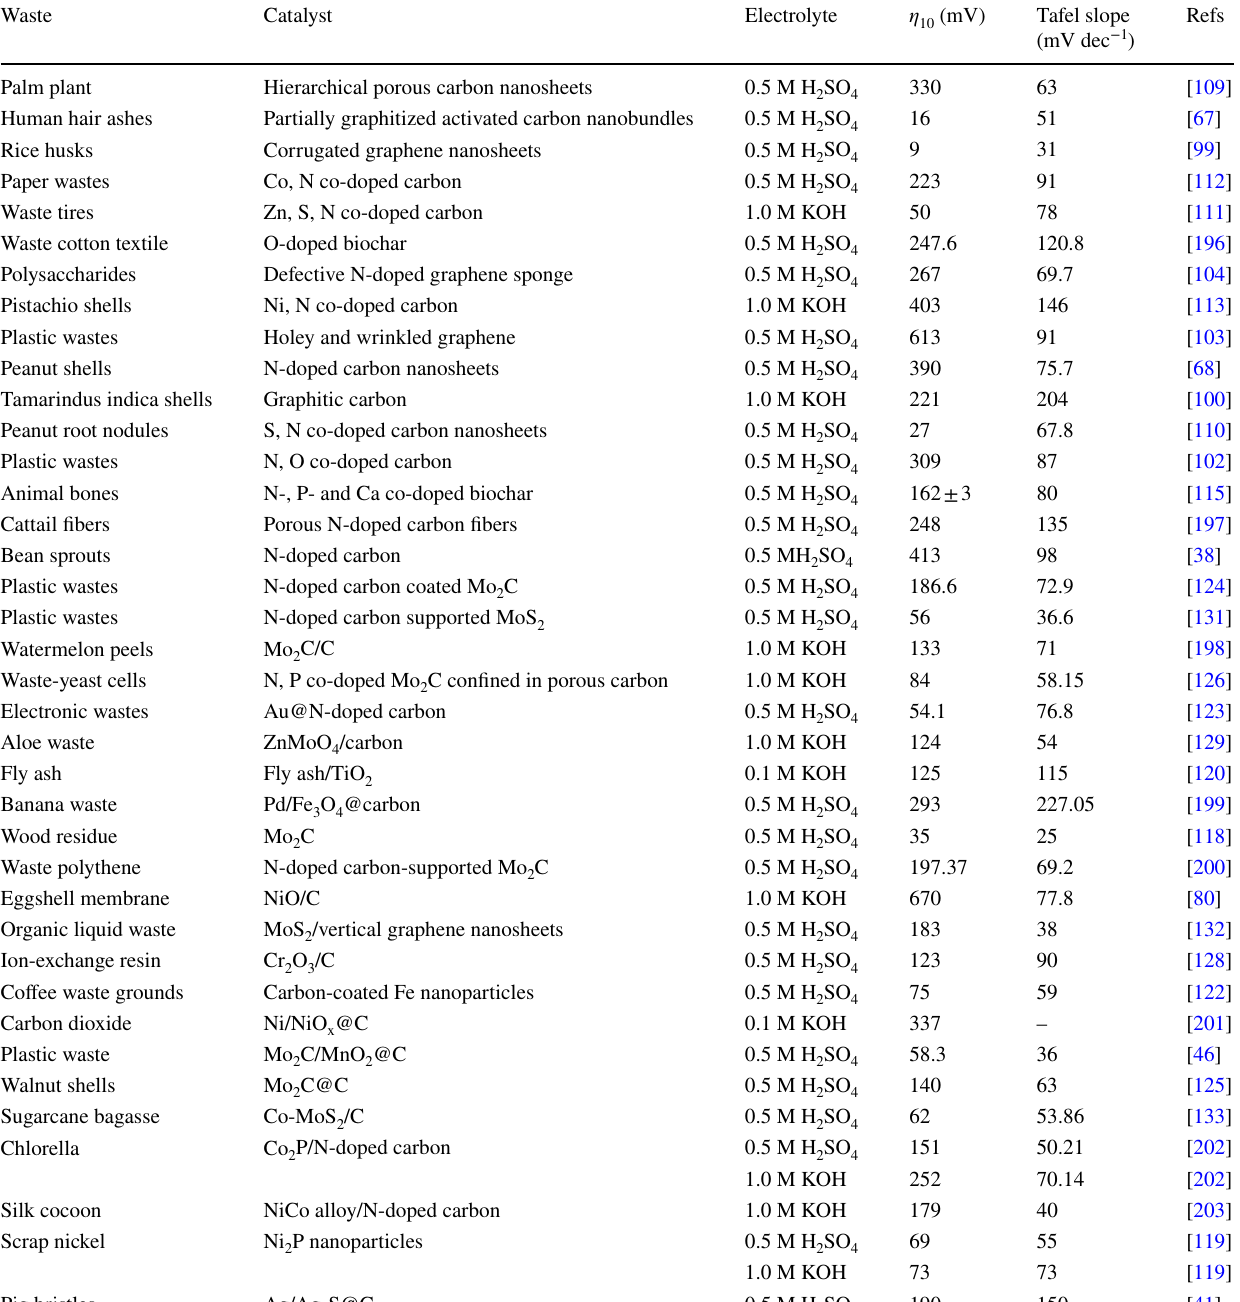
Table 1 Summary of representative waste‑derived HER electrocatalysts Waste